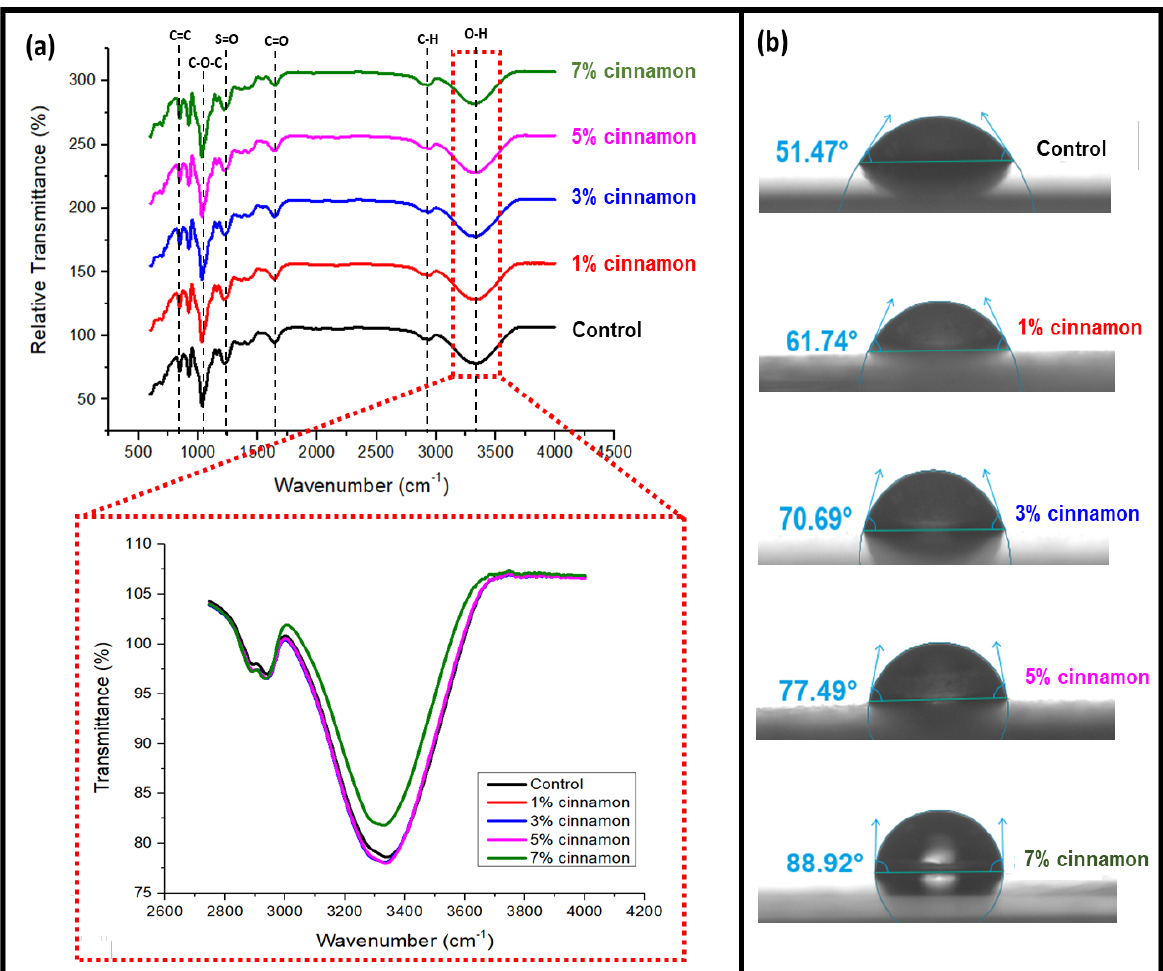
Figure 2. ( a ) FT-IR analysis of seaweed-based cinnamon film. ( b ) Contact angle thickness of seaweed-based film incorporated with cinnamon powder.